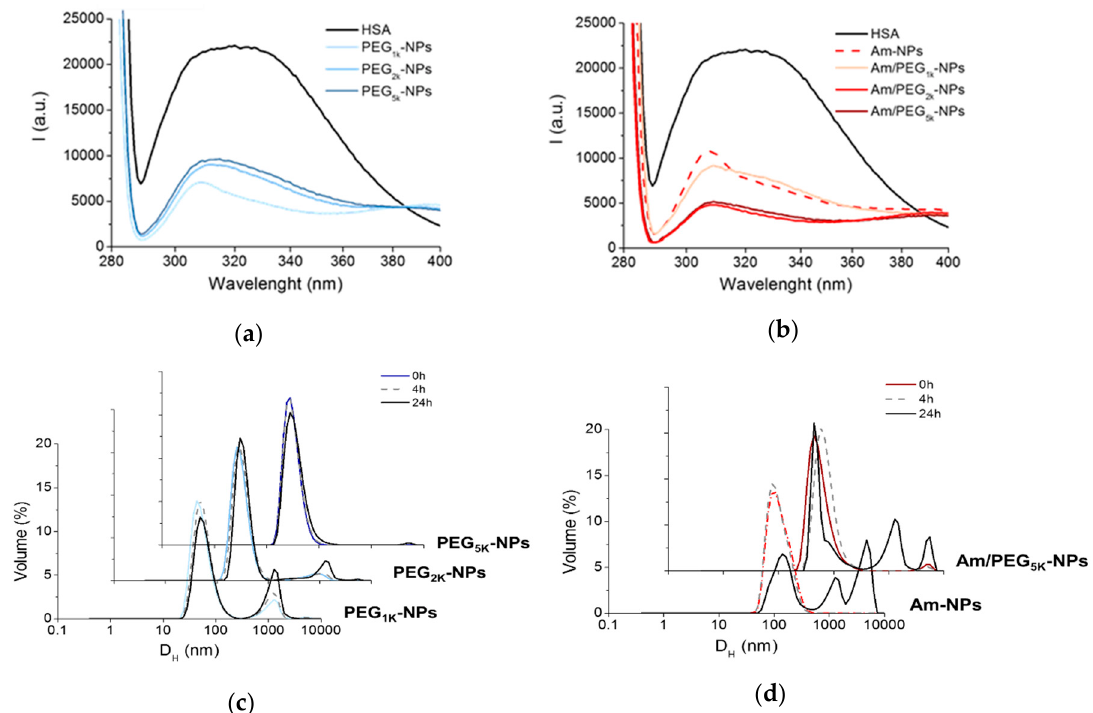
Figure 4. Interaction of NPs with proteins. Fluorescence emission spectra of HSA (0.2 mg / mL) at Ex = 278 nm in the presence of PEG-NPs ( a ) and Am-NPs or Am / PEG-NPs ( b ) (NPs = 0.5 mg / mL). Spectrum of free HSA is reported as control. Representative size distribution curves of PEG-NPs ( c ) and Am-NPs or Am / PEG-NPs ( d ) incubated in HSA (0.2 mg / mL) (NPs = 0.5 mg / mL).